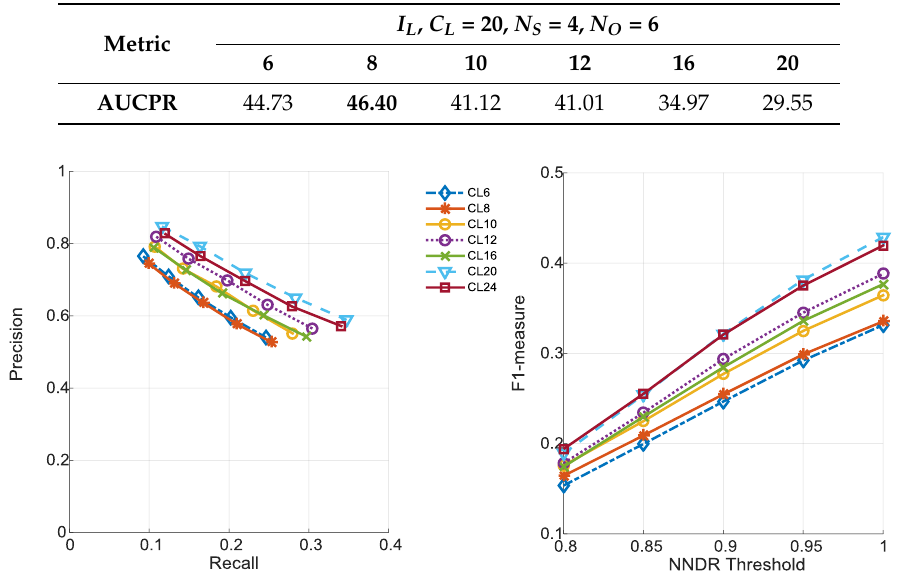
Table 3. The AUCPR (%) results of parameter IL.